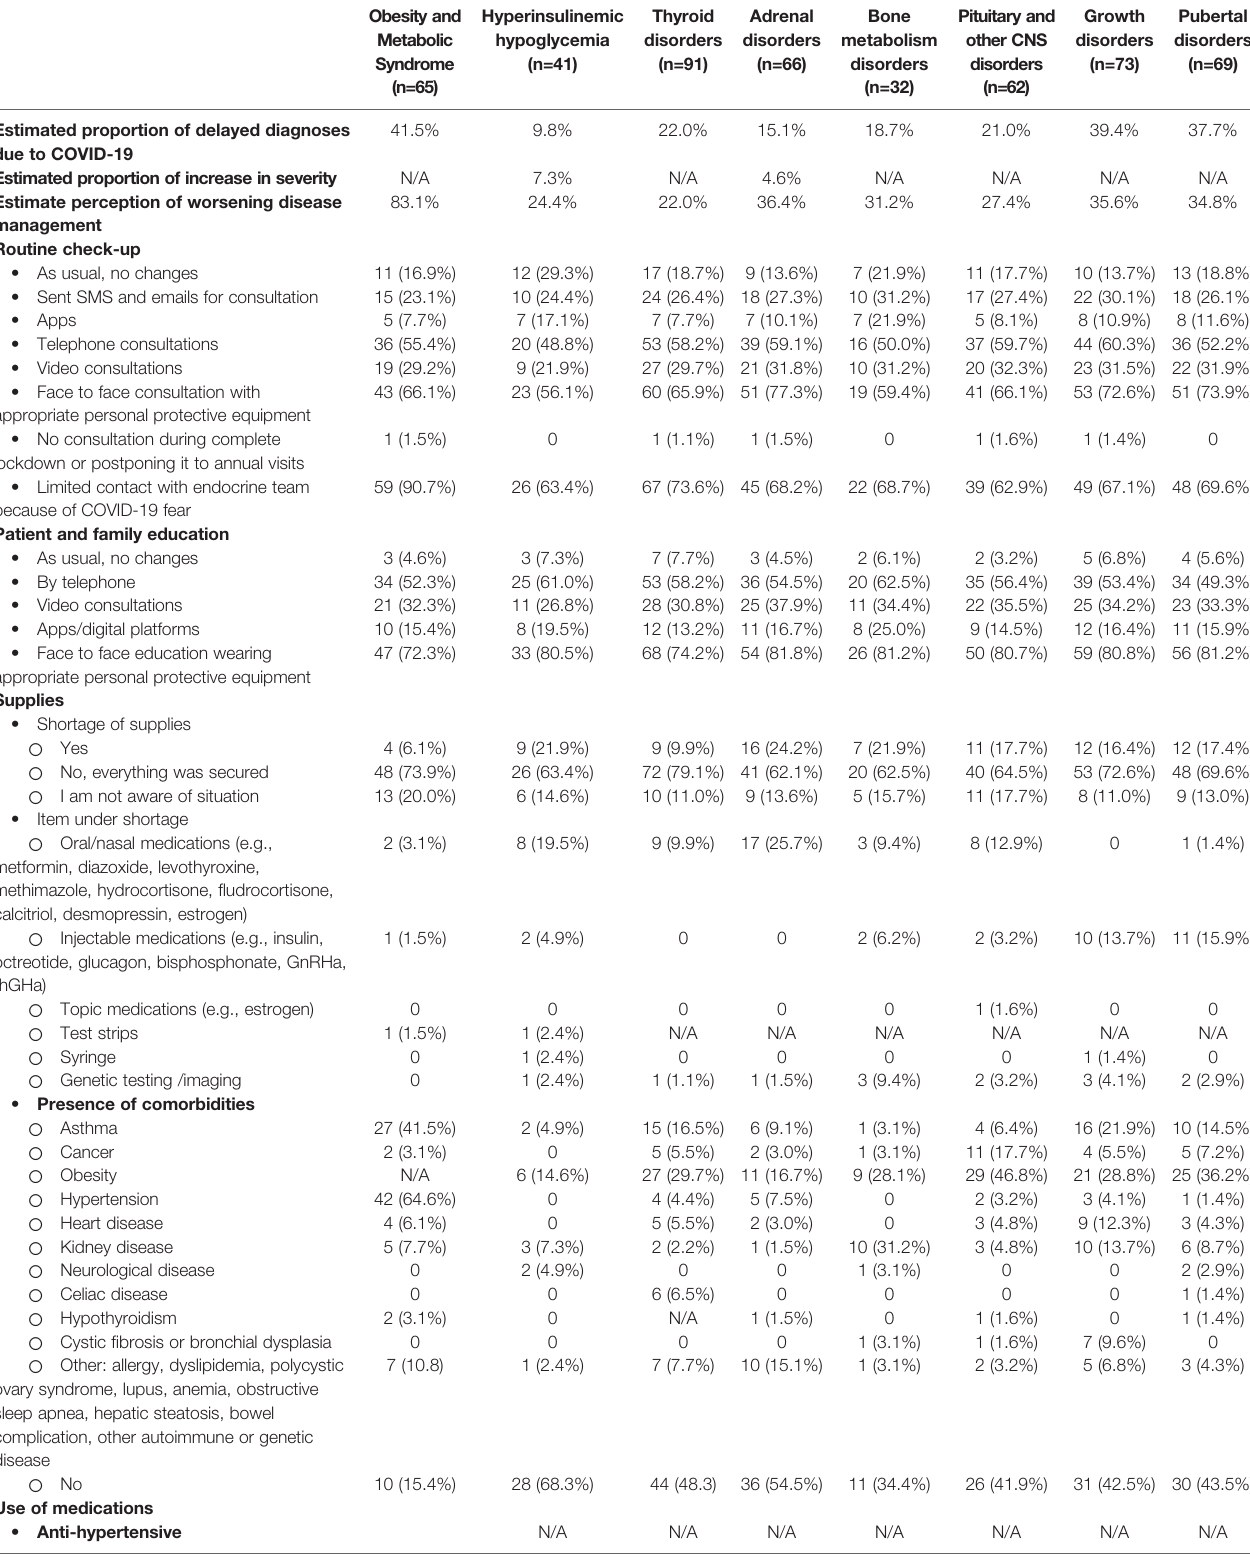
TABLE 3 | Assessment of pediatric endocrine care other than diabetes during COVID-19 pandemic by clinical